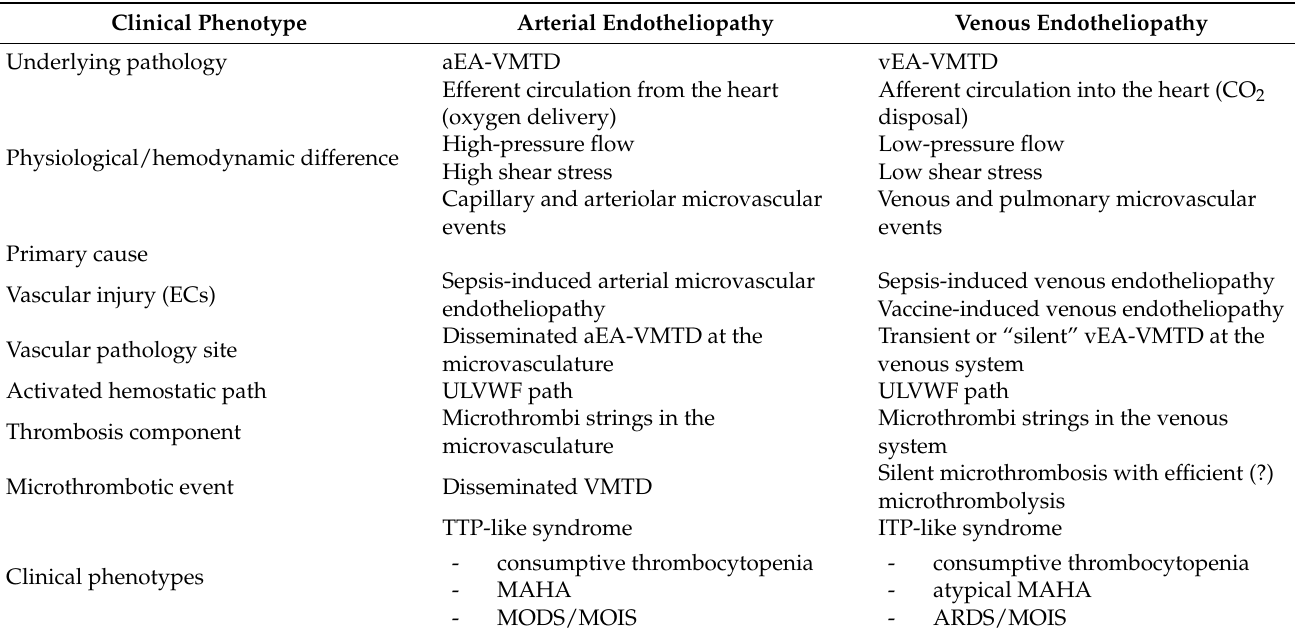
Table 4. Clinical phenotypes and mechanisms of endotheliopathy in arterial and venous systems per the “two-activation theory of the